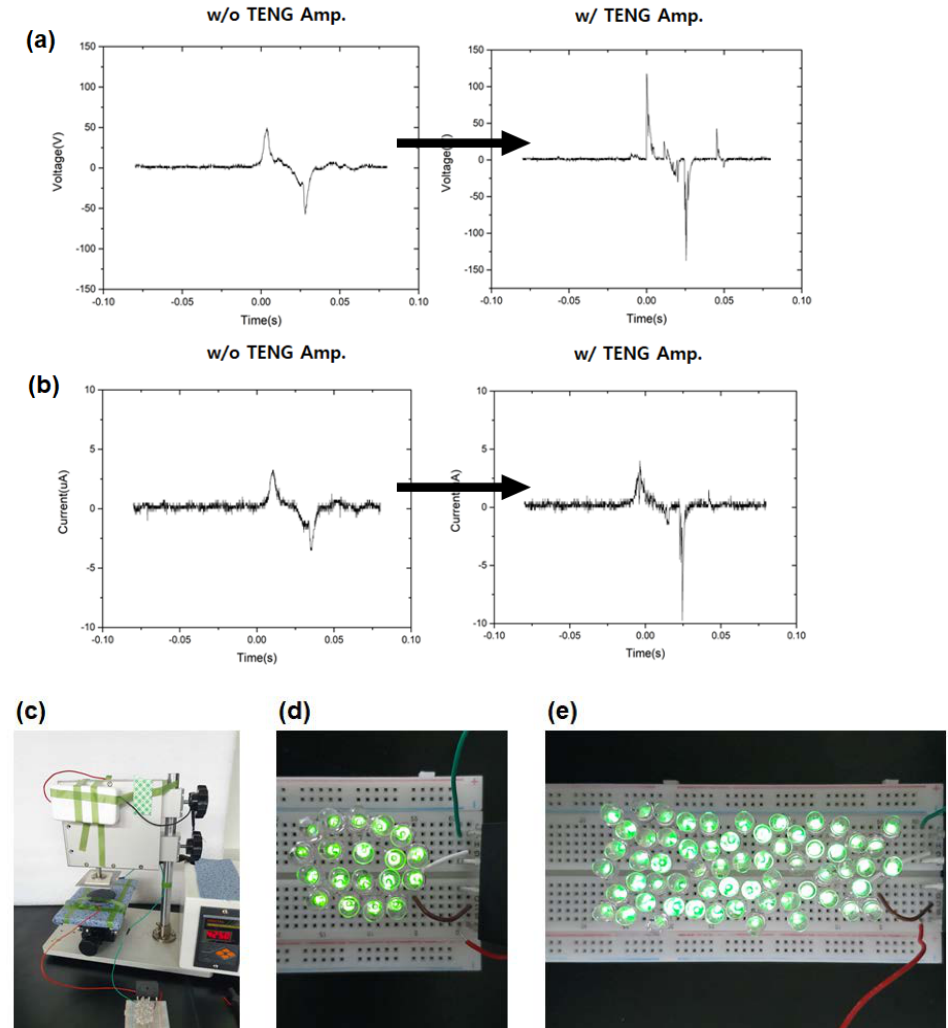
Figure 6. Comparison of the output performance of the conductive sponge TENG specimen with and without the amplifier: ( a ) comparison of voltage outputs for a single interval; ( b ) comparison of current outputs for a single interval; ( c − e ) comparison of the number of LEDs with and without the amplifier being connected to the conductive TENG specimen. Table 1. Comparison of rms values of TENG output performance with and without the amplifier. Voltage Current Power Output (rms, V) (rms, A) (rms, W) w/o TENG Amp.